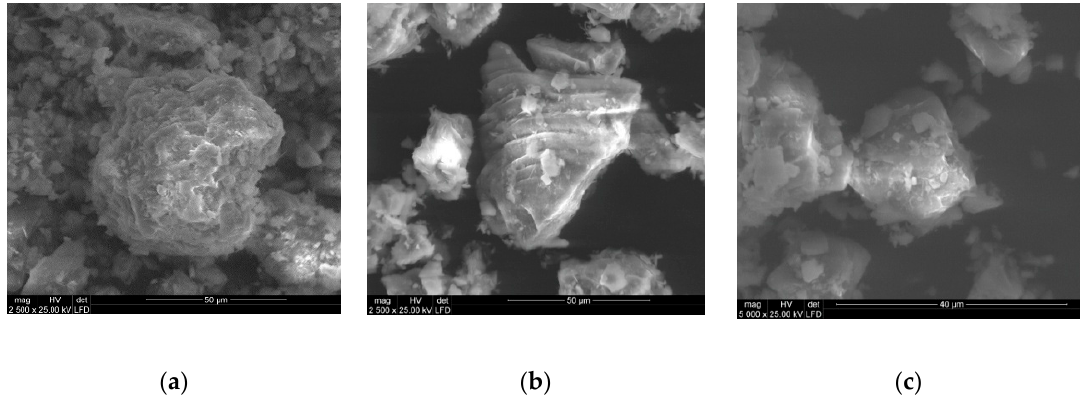
Figure 4. Examples of SEM images of copper ore particles comminuted in a hydro-jet mill at a water jet pressure of 150 MPa: ( a )—carbonate, ( b )—sandstone, ( c )—shale ore.